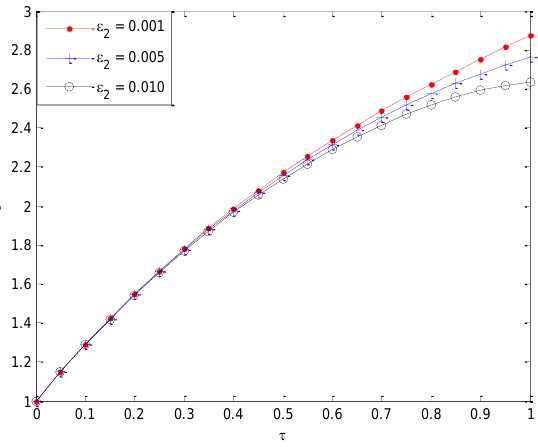
 on the temperature profile. 2